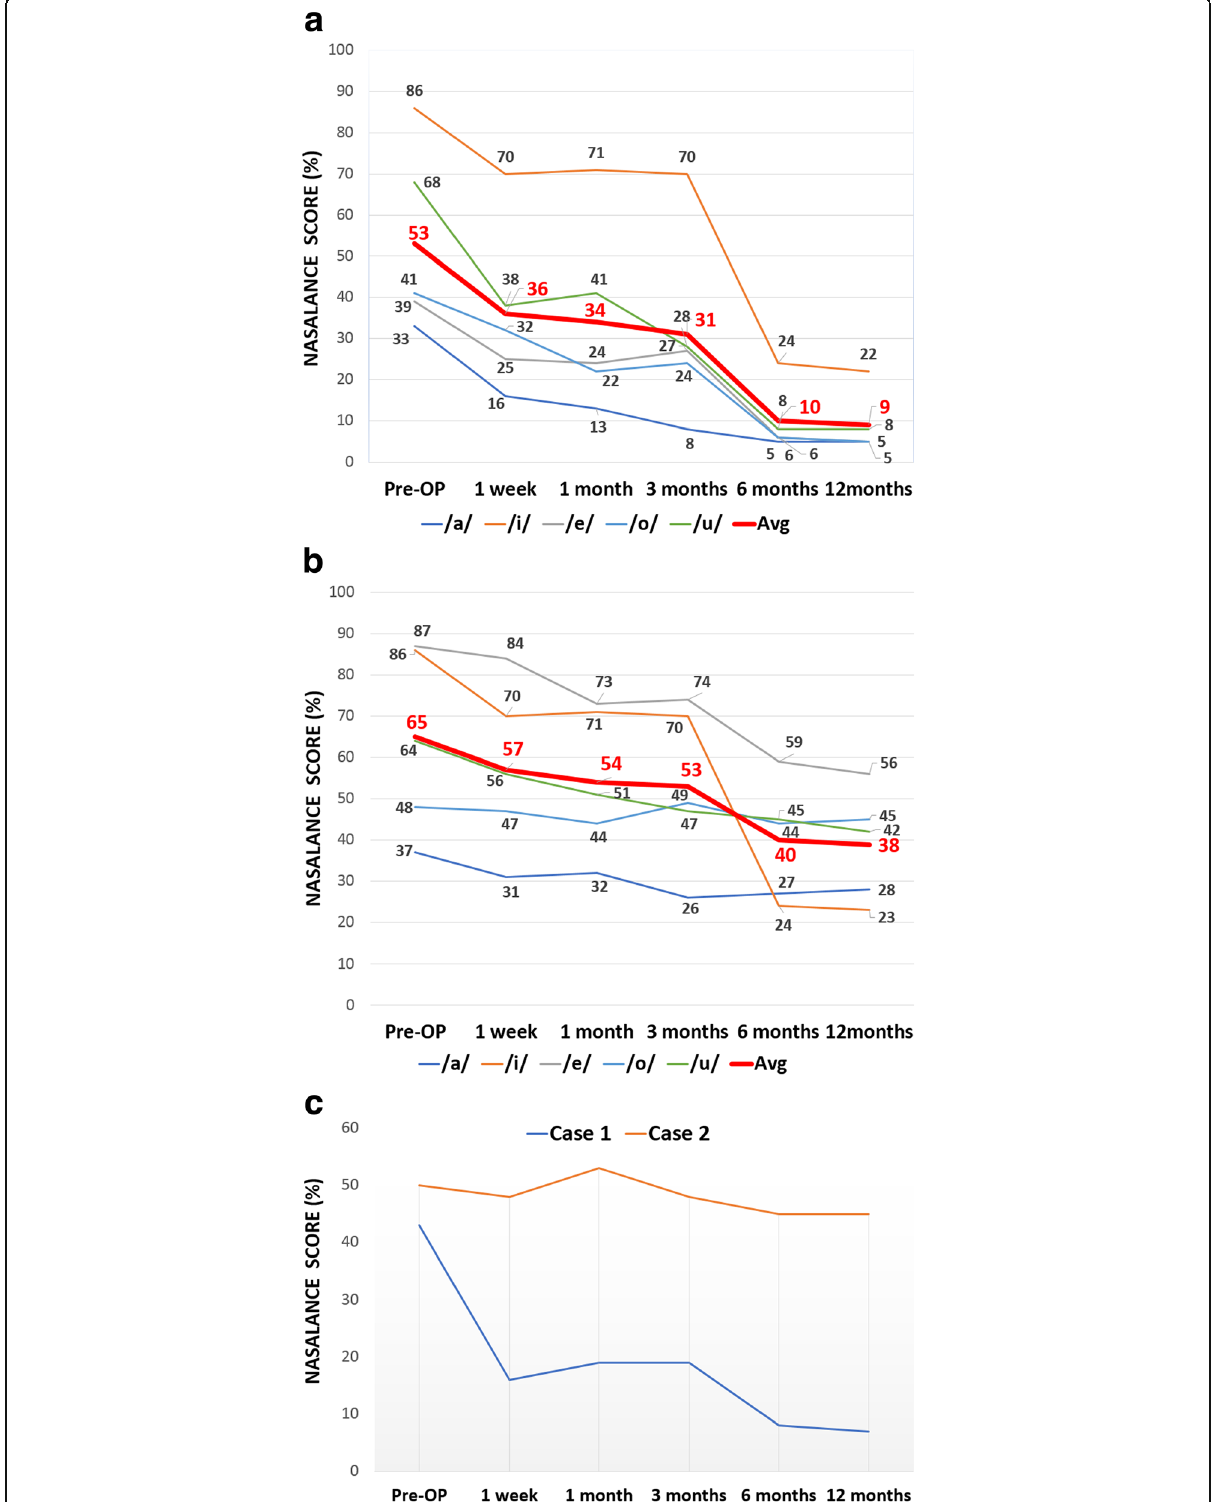
Fig. 3 Graph of nasalance score over time. a Nasalance score (%) for five simple vowels and the average value (thick red line) in case 1. b Nasalance score for simple vowels in case 2. c Nasalance score measured during sentence